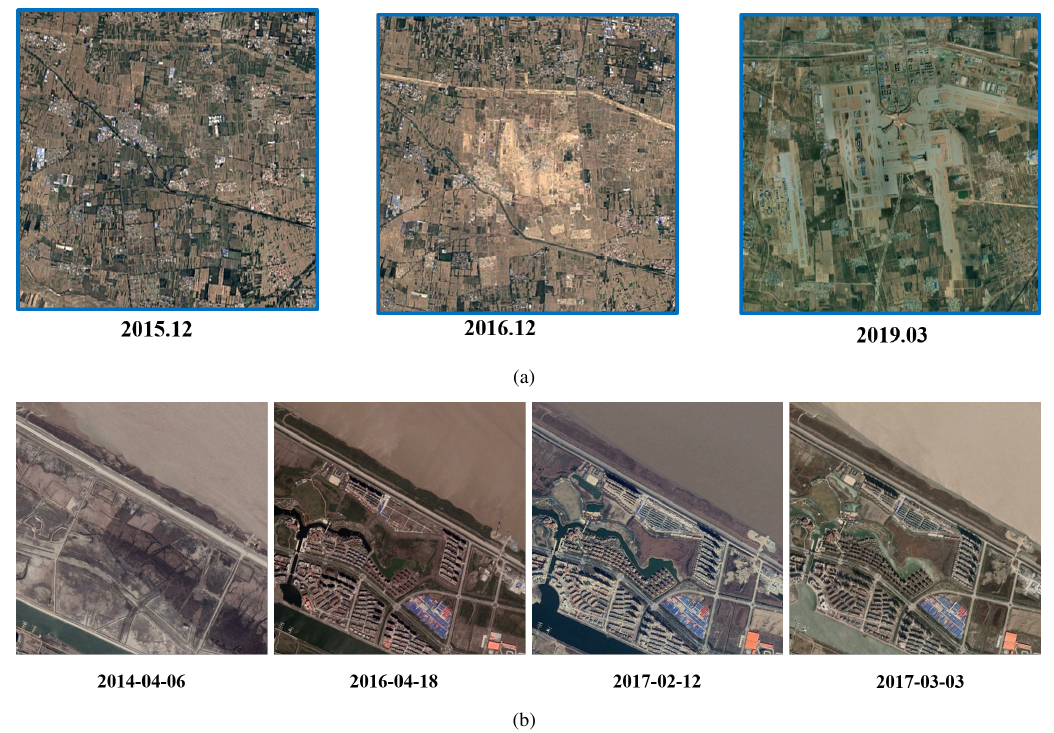
Figure 6. Validating change patterns using Google Earth historical images:(a) Beijing Daxing International Airport - see Fig. 4(d); (b) the island in the Yangtze River Delta - see Fig.